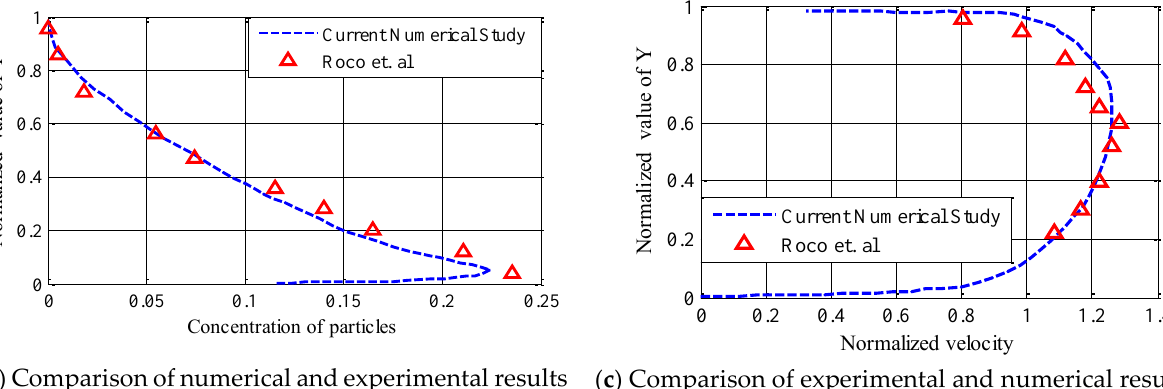
Figure 9. Pressure and erosion rate density contours on the walls of the impeller and casing walls.